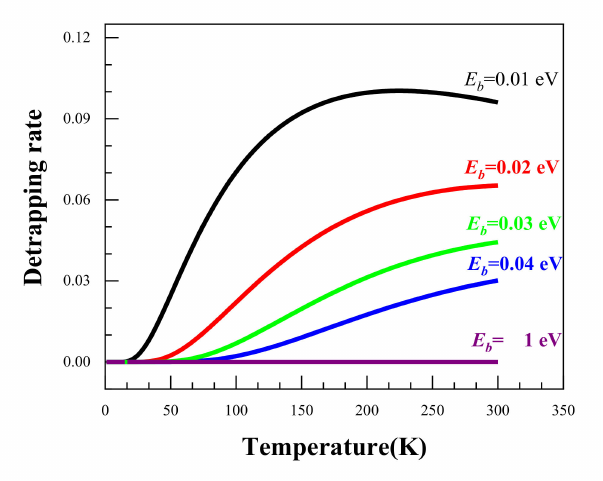
Figure 6. The temperature dependence of the positron detrapping rate at different binding